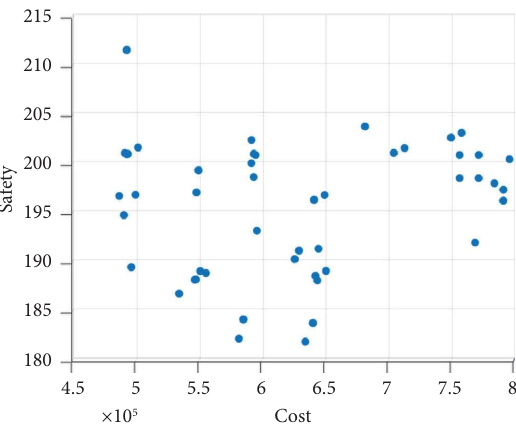
Figure 8: Cost-safety trade-of.